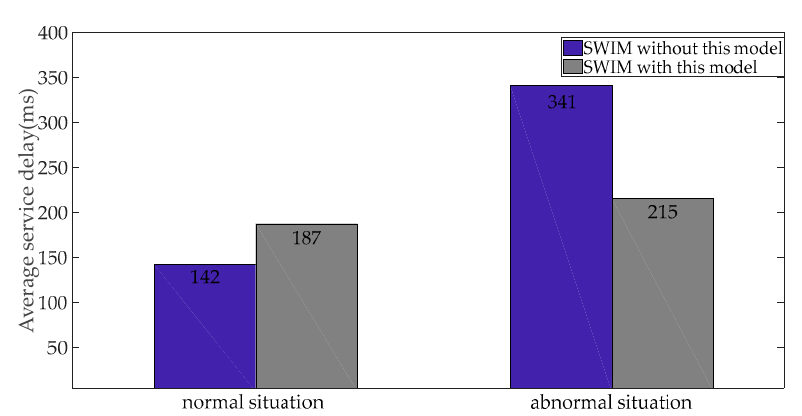
Figure 14. Average service delay comparison.